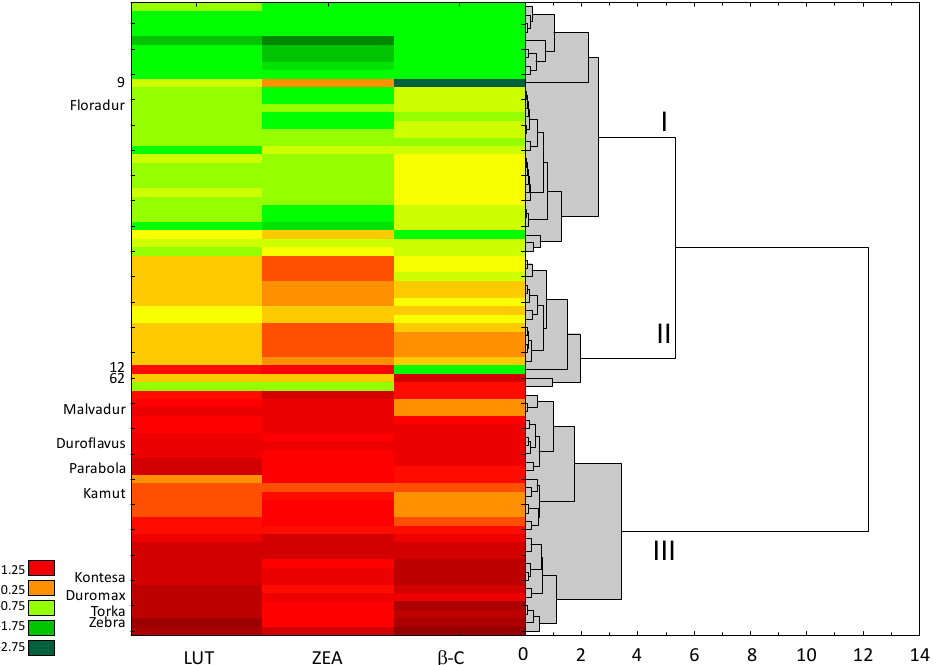
Figure 2. The results of cluster analysis investigating the concentrations of three carotenoids in the grain of the analyzed T. polonicum lines versus four durum wheat cultivars (Floradur, Duroflavus, Malvadur, and Duromax), four bread wheat cultivars (Kontesa, Parabola, Torka, and Zebra) and Kamut ® wheat. LUT—lutein, ZEA—zeaxanthin, β -C— β -carotene. 9, 12, 62—distinctive T. polonicum lines. I, II, III indicate the main clusters.